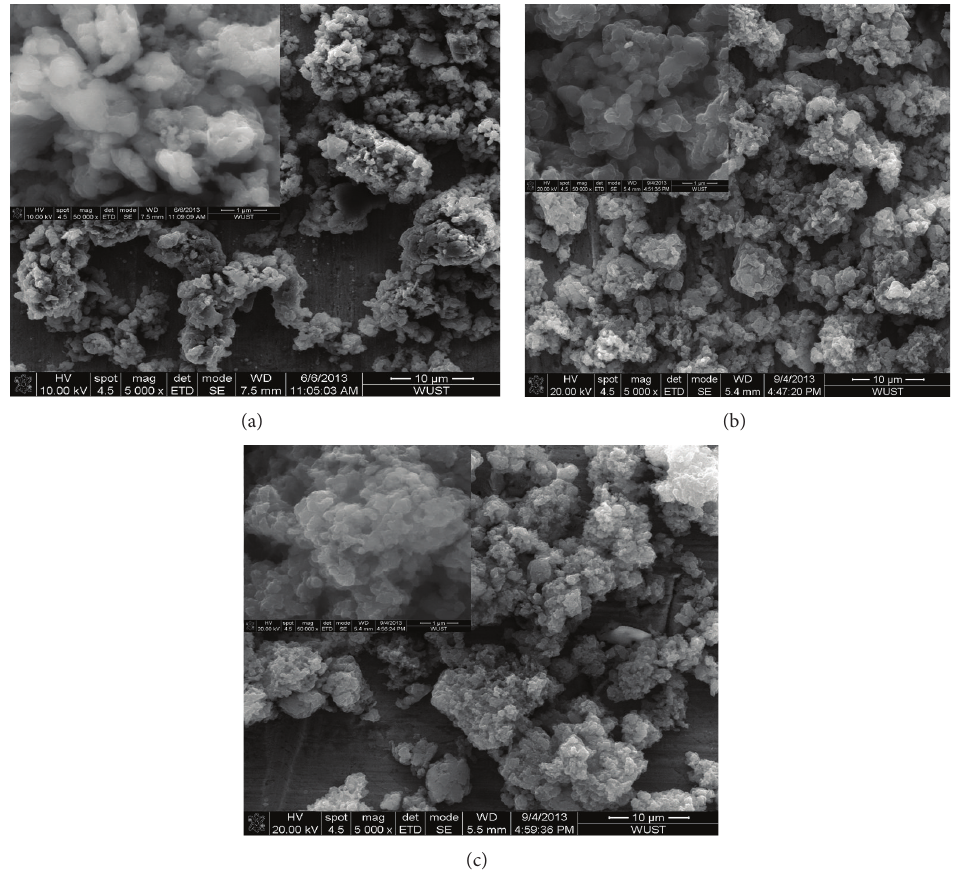
Figure 2: SEM images of PANI ((a) original PANI; (b) PANI immersed in 1MHCl; (c) PANI immersed in 1MH 2 SO 4